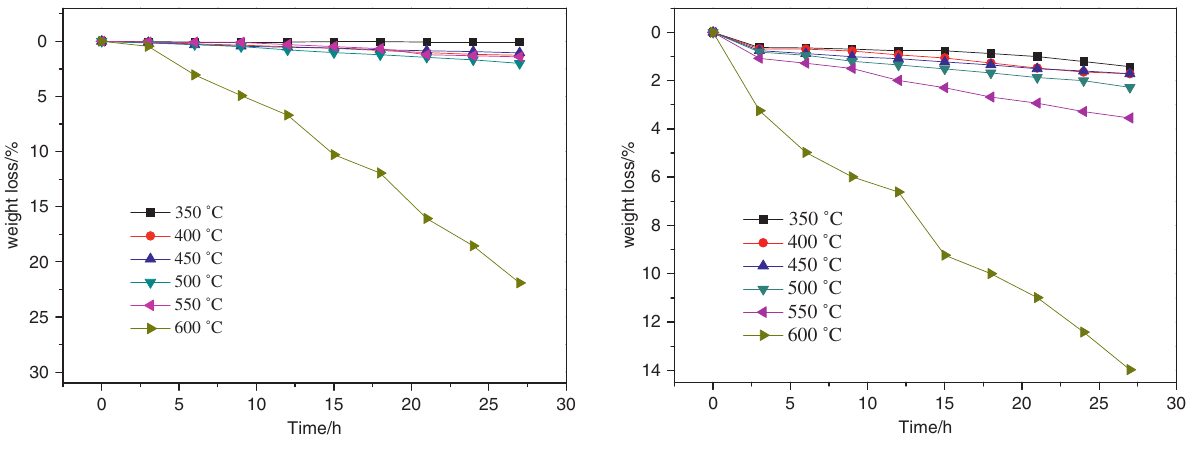
Figure 5: Weight loss vs time of Solar Salt at different temperatures.